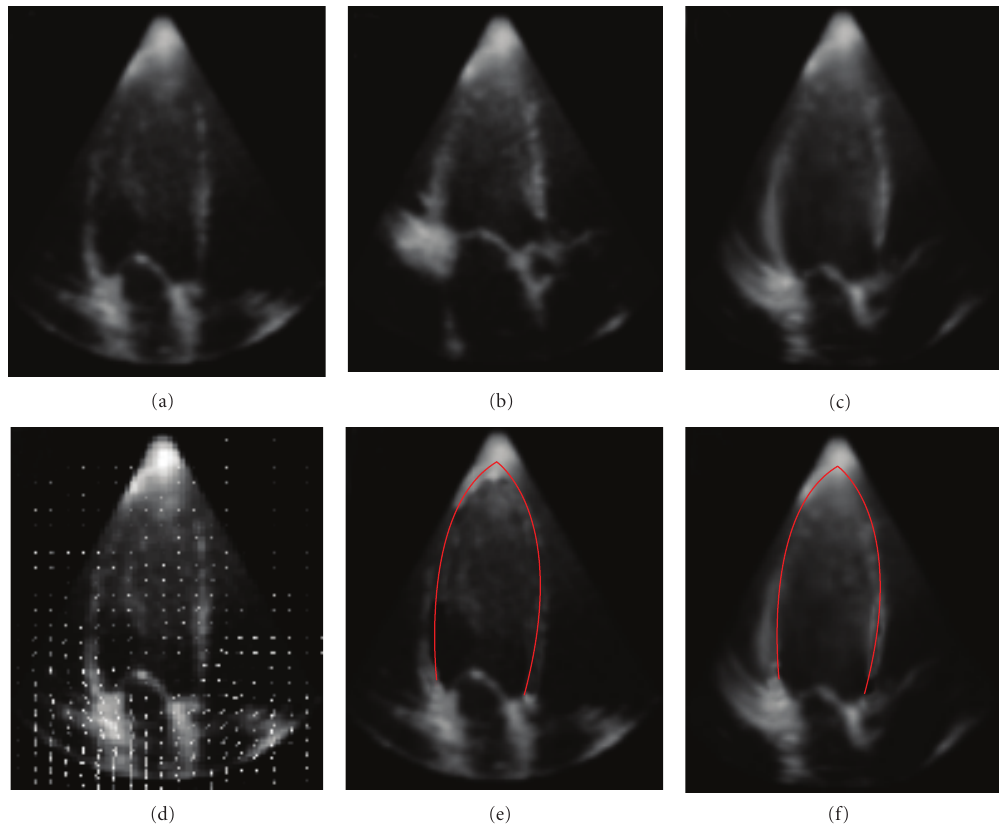
Figure 2: Example of motion estimation in a cardiac ultrasound sequence. (a) Original slice at end diastole. (b) Original slice at end systole. (c) Image (b) after alignment to image (a). (d) Estimated motion vector field, shown superimposed on (a). (e), (f) Images (a) and (c), respectively, with the endocardial contour superimposed. Note how the shapes are matched by the motion estimation process and all motion estimation and resampling were performed in 3D; a sample 2D slice is shown for